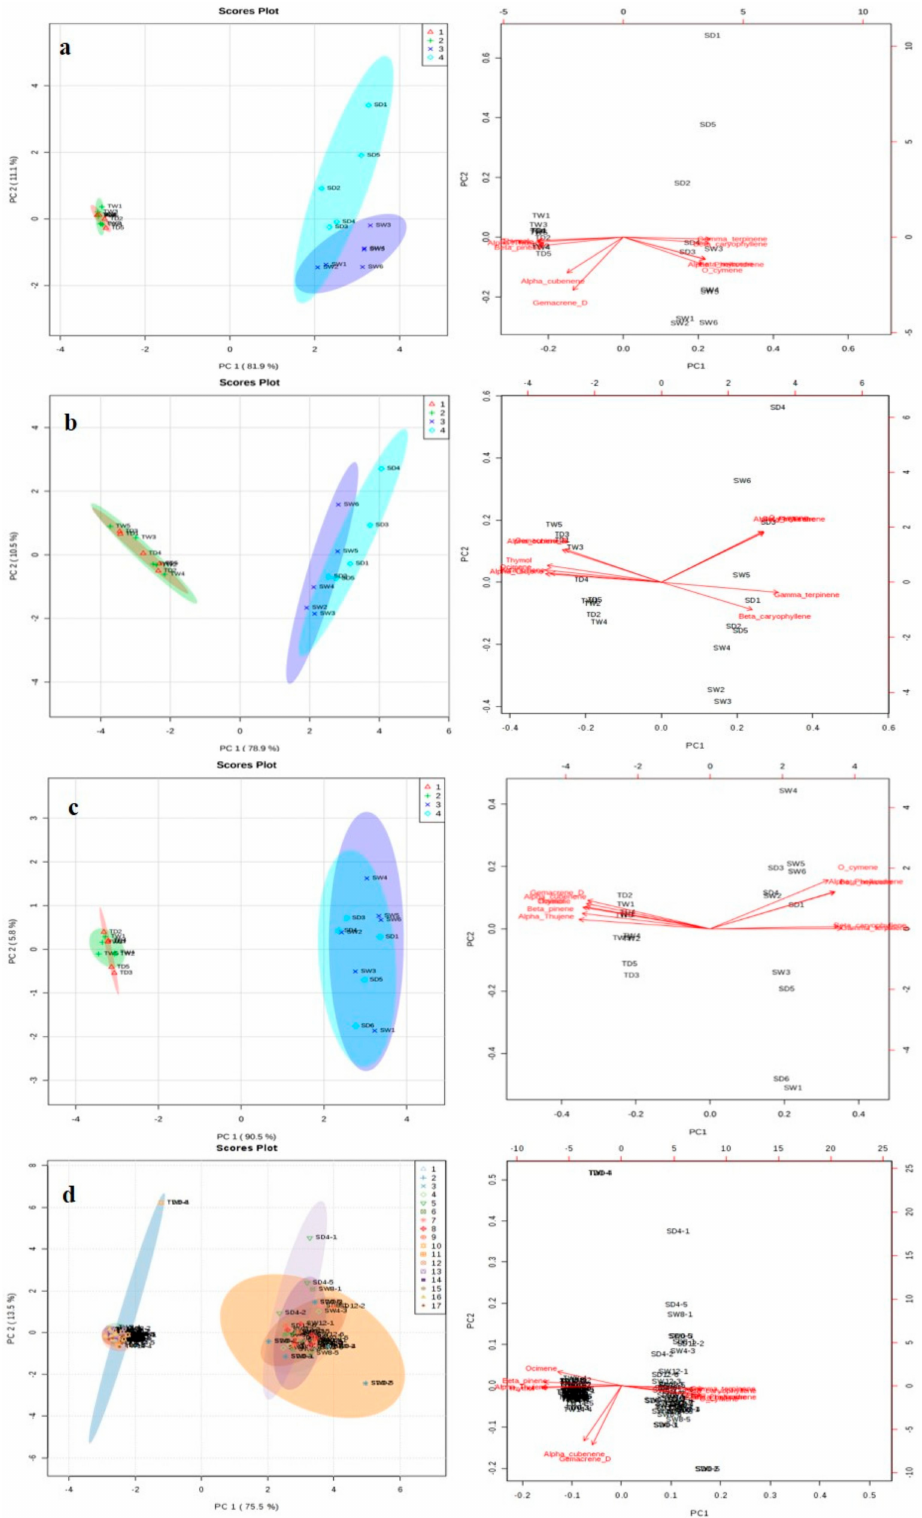
Figure 4. Principal component analysis (PCA) and partial least squares-discriminate analysis (PLS-DA) score plots for the volatile compounds in the tolerant and sensitive thyme leaves under control and drought stress conditions. Score plots for the tolerant watered (TW), tolerant drought-stressed (TD), sensitive watered (SW) and sensitive drought-stressed (SD) leaves after four ( a ), 8 ( b ) and 12 ( c ) days of water limitation. ( d ) The total plots (days 0–14). The numbers present the corresponding sample